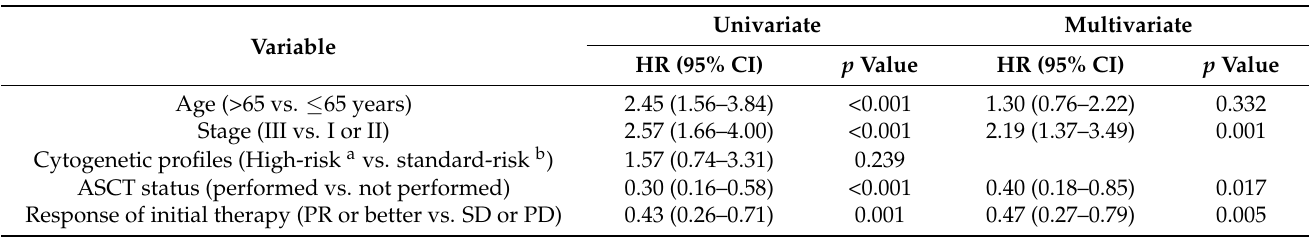
Table 4. Univariate and multivariate analysis of clinical factors influencing overall survival from initial